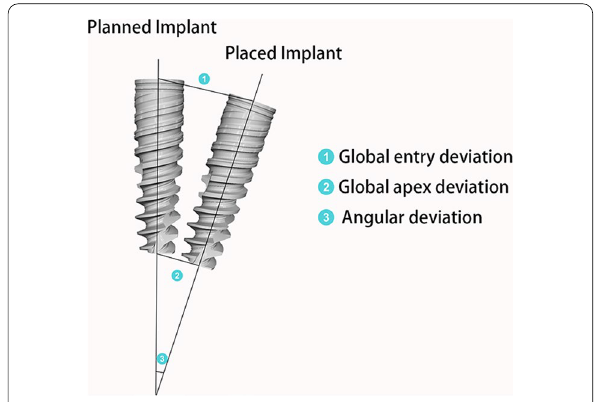
Fig. 5 Accuracy measurement of the primary